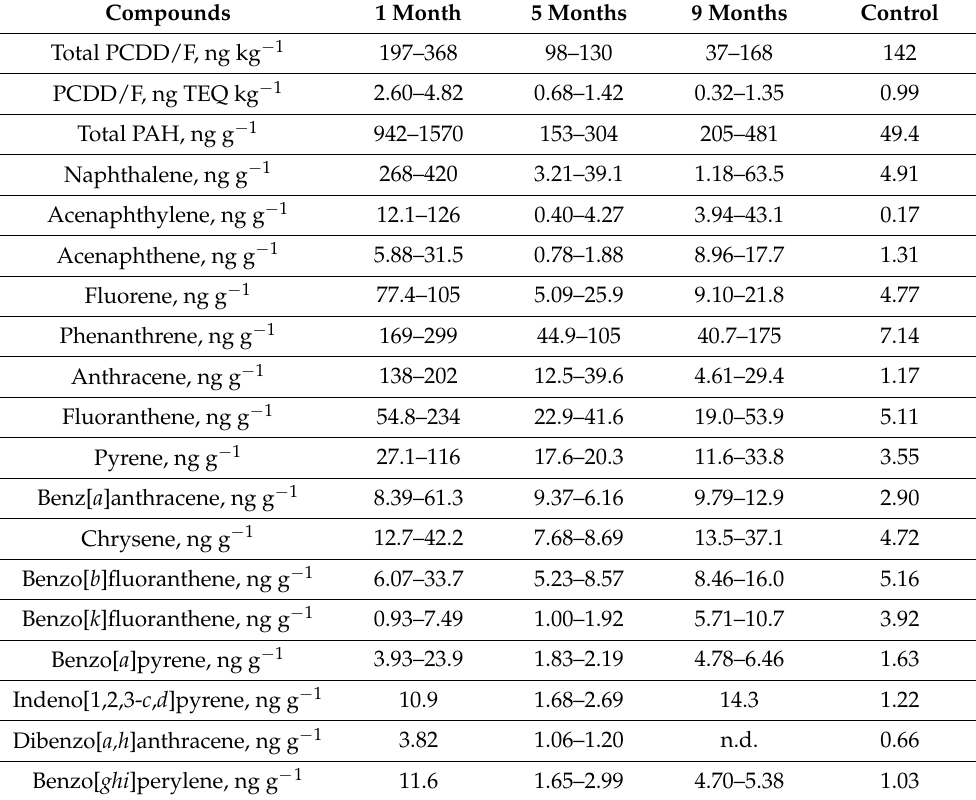
Table 13. Concentrations of PCDD/F and PAH in the burnt and unburnt soils 1, 5, and 9 months after a forest fire. Data from